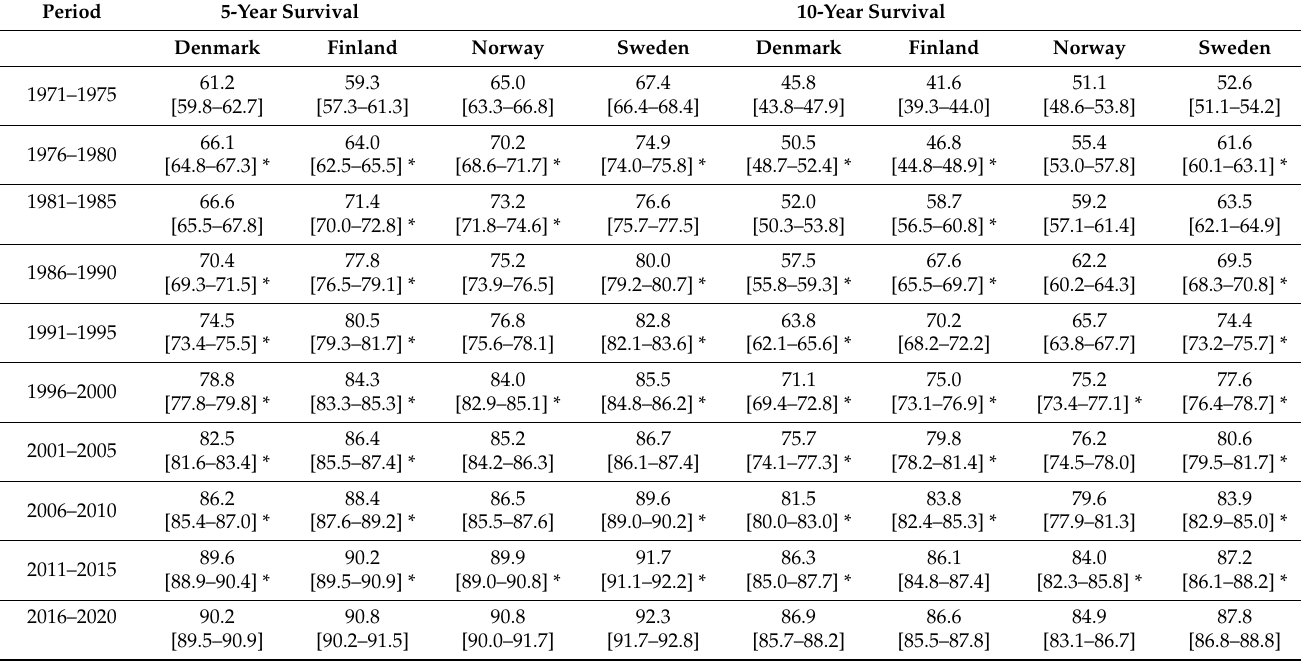
Table 1. Breast cancer relative survival (%, [95% confidence interval]) in the Nordic countries.